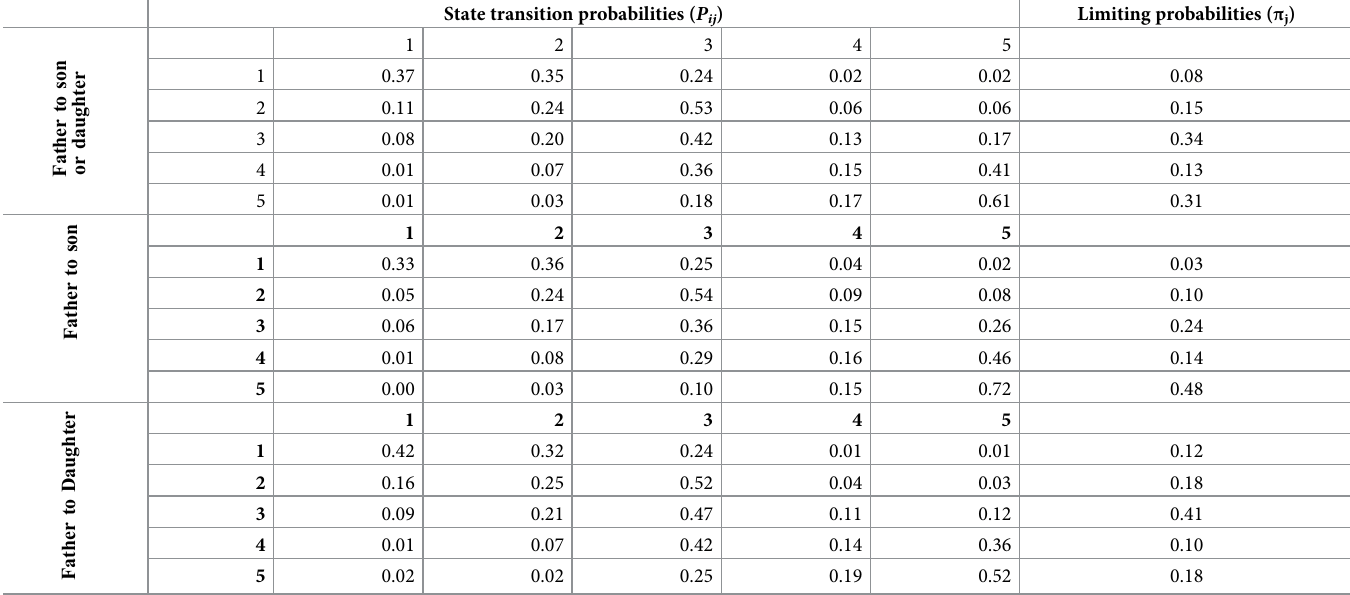
Table 3. Estimated educational class transition probabilities in Bangladesh.